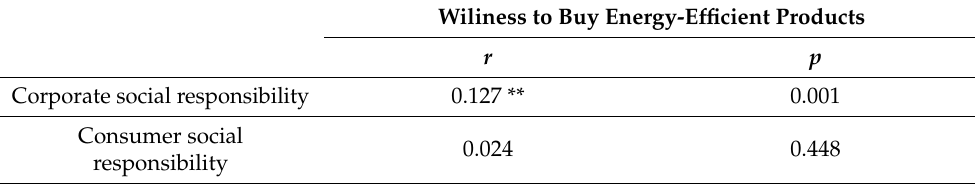
Table 4. Correlation coefficients between buying energy-efficient products and negative evaluations of corporate and consumer social responsibility.